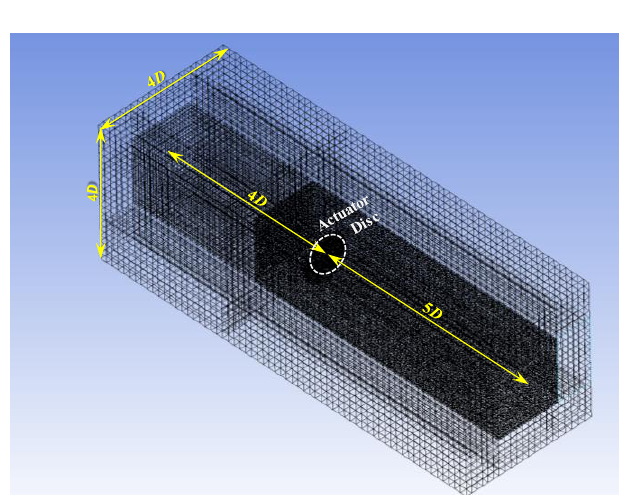
Figure 7. CFD domain.